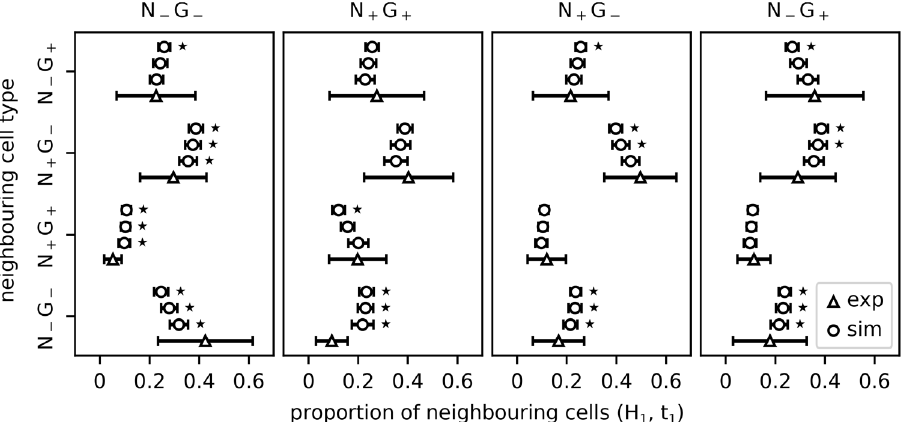
Figure 3. Expression type composition of neighbouring cells as percentage of the total of neighbouring cells at t 1 . Simulations were performed under the assumption H 1 . Experimental data from Mathew et al. are indicated by triangles. Simulation results for different t 0 are indicated by circles. The error bars indicate the standard deviation. t 0 from lowest line to top: 200, 300 and 400 cells. Statistically significant differences between the neighbourhood structure of 24 h old ICM organoids and ICM spheroid patterns are indicated by stars ( p < 0.05 ; using a Wilcoxon–Mann–Whitney test with Bonferroni